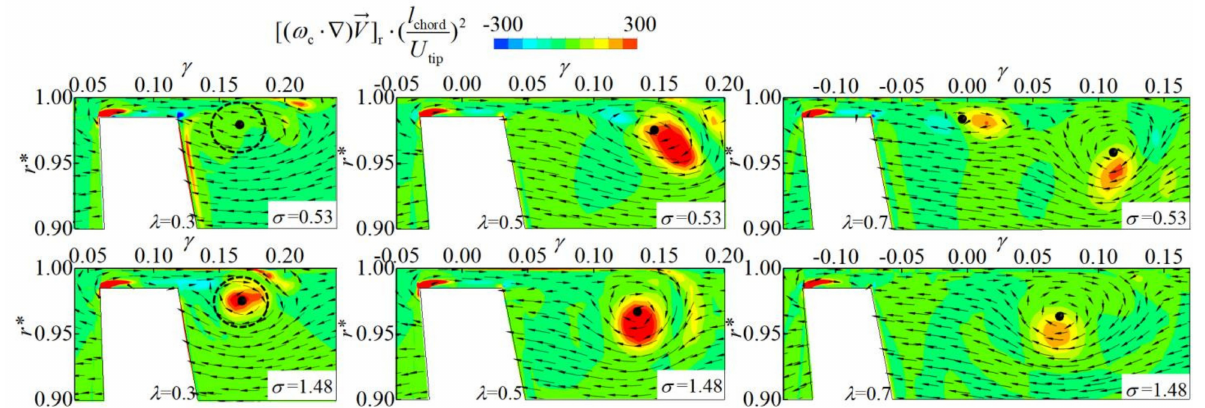
Figure 20. Comparison of the radial bending term distribution on the three planes for the cavitating case ( upper ) and non-cavitating case ( lower